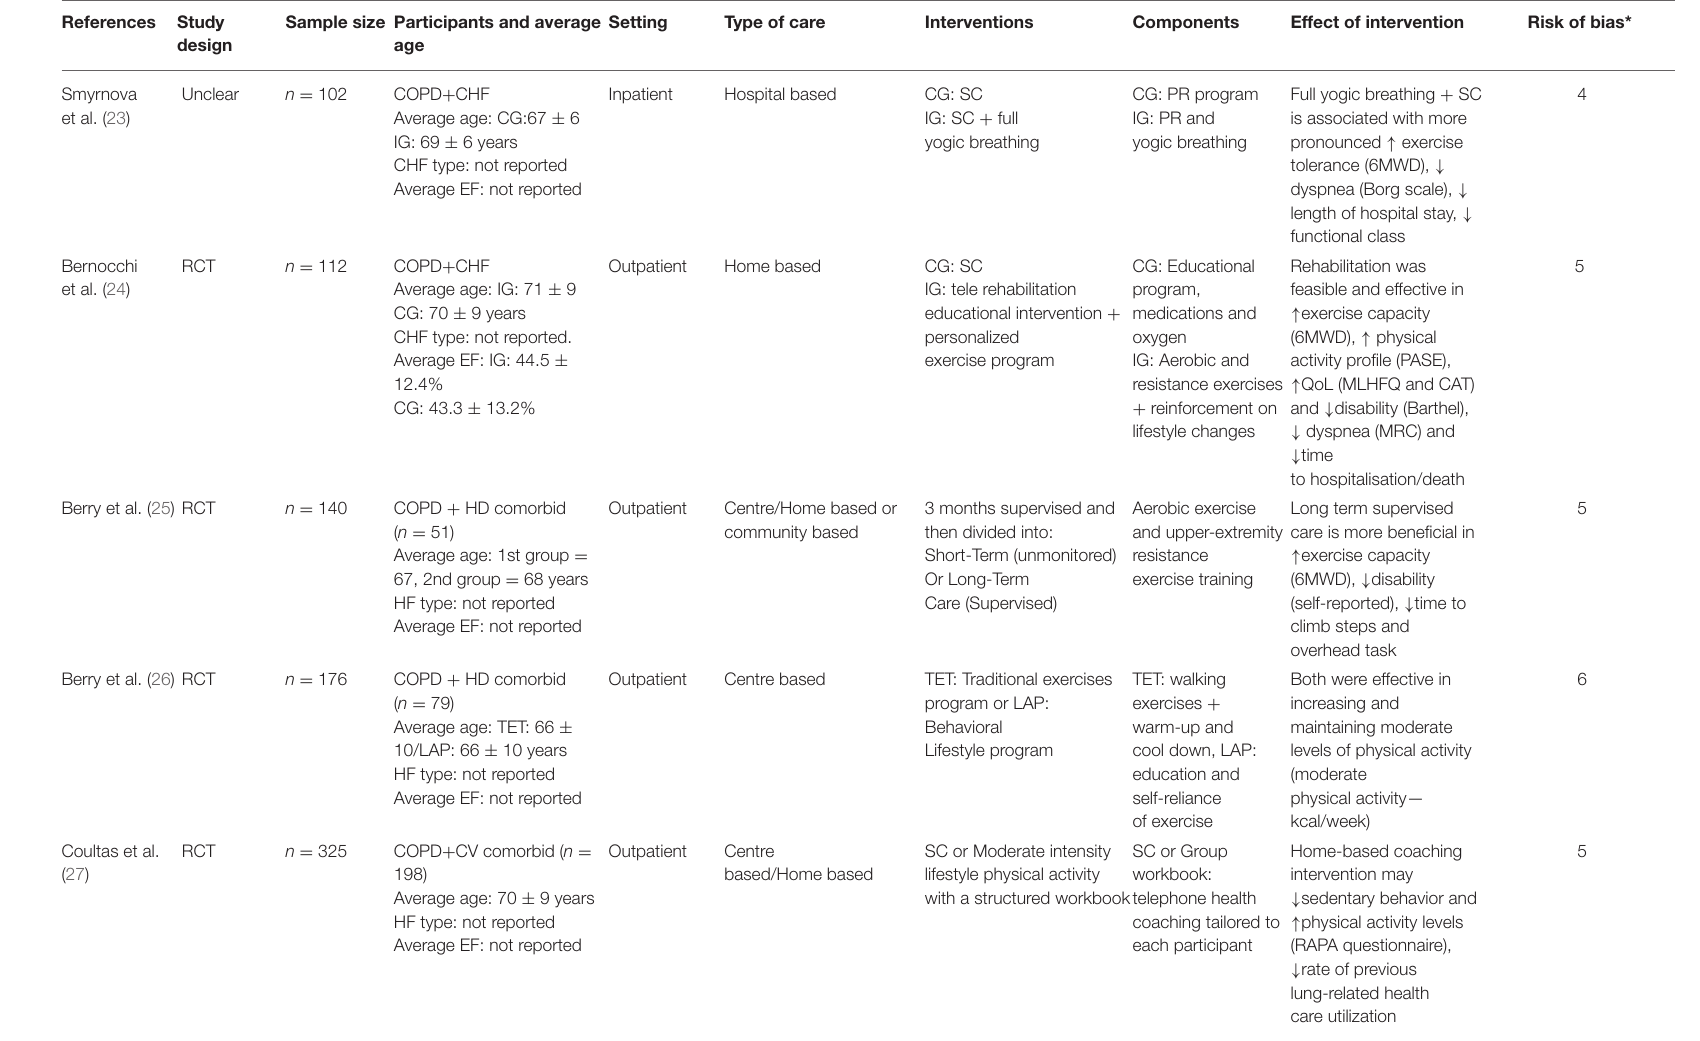
TABLE 1 | Exercise-base rehabilitation models and their effects on the population with COPD-CHF or COPD-Cardiovascular comorbidities. References Study